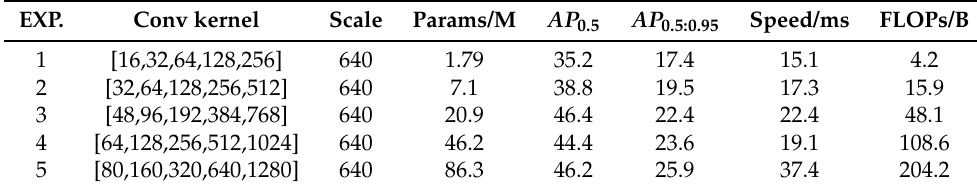
Table 7. The ablation study of Conv